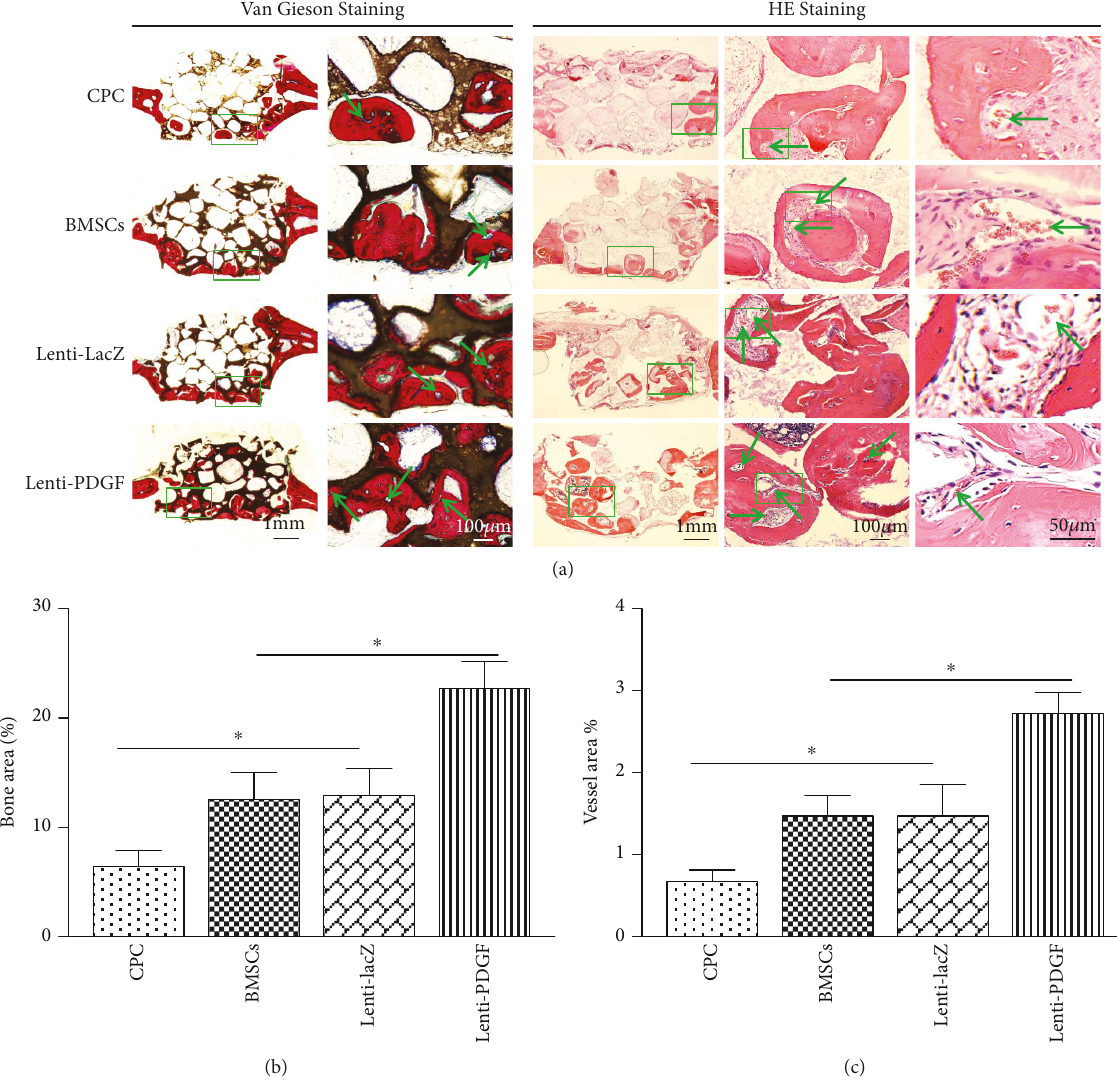
Figure 7: Histological analysis of newly formed bone and blood vessel in implants. (a) Histological images of each group. Left panel: Van Gieson staining, the new bone appears red, CPC appears black, and blue spots indicate blood vessels (green arrow); right panel: HE staining. The newly formed bone tissue was in fi ltrated with blood vessels (green arrow) with intraluminal red blood cells. (b) Histomorphometric analysis of the newly formed bone area. (c) Histomorphometric analysis of newly formed vessel area. ∗ P < 0 05